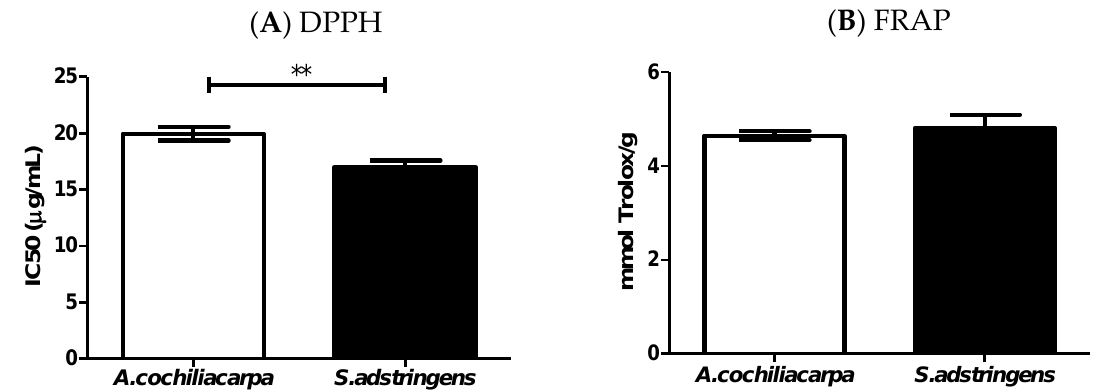
Figure 3. A. cochliacarpa and S. adstringens extracts obtained by turbo extraction and evaluated by the ( A ) DPPH (** p < 0.01) and ( B ) FRAP ( p > 0.05) methods.